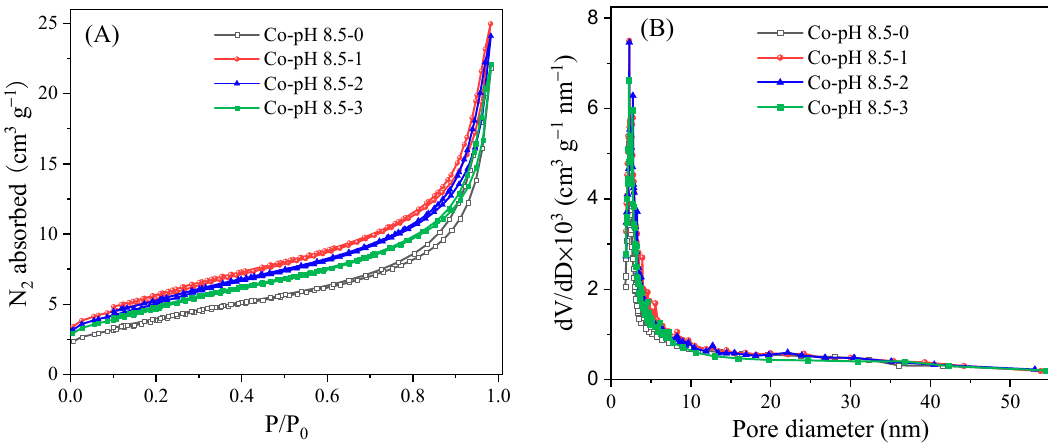
Figure 9. ( A ) N 2 adsorption − desorption isotherms and ( B ) pore size distributions of cobalt